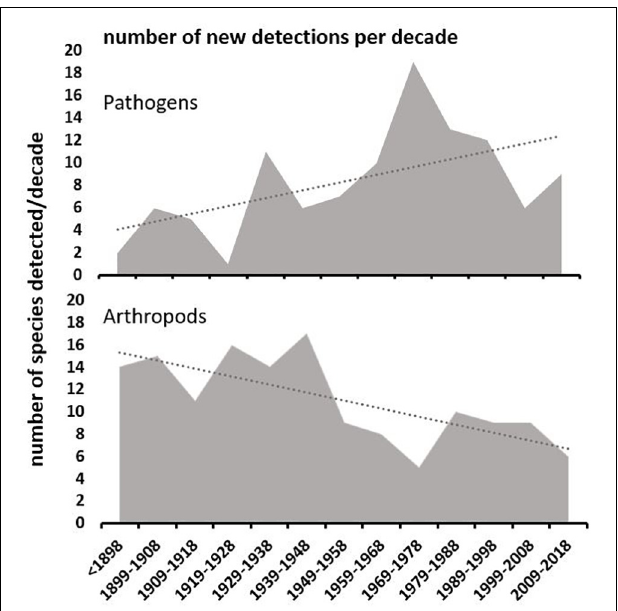
FIGURE 2 | Number of new non-native forest pathogen and arthropod detections recorded each decade to 2018. The trendlines are significant at P < 0.05 (see